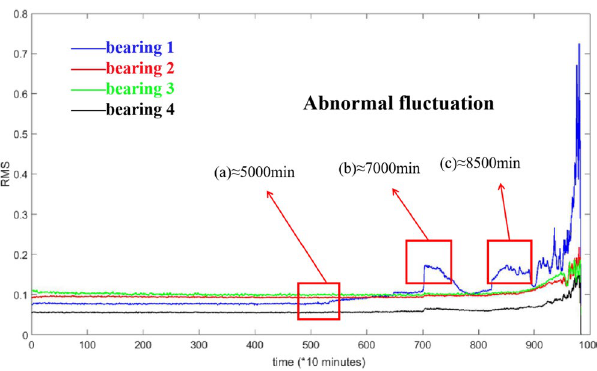
Figure 5. Process of bearing RMS for dataset